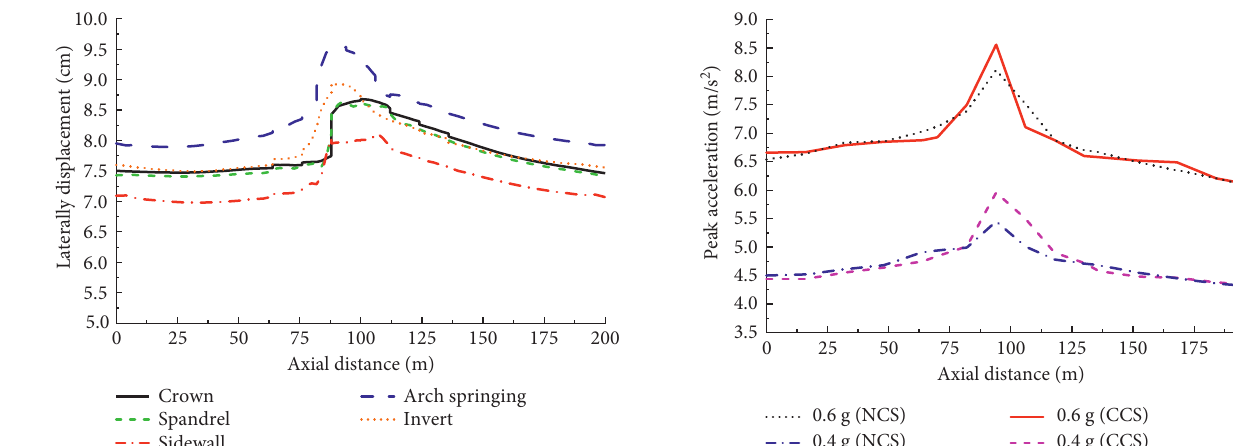
Figure 13: Distribution curve of the laterally displacement of typical parts of the lining along the axial.